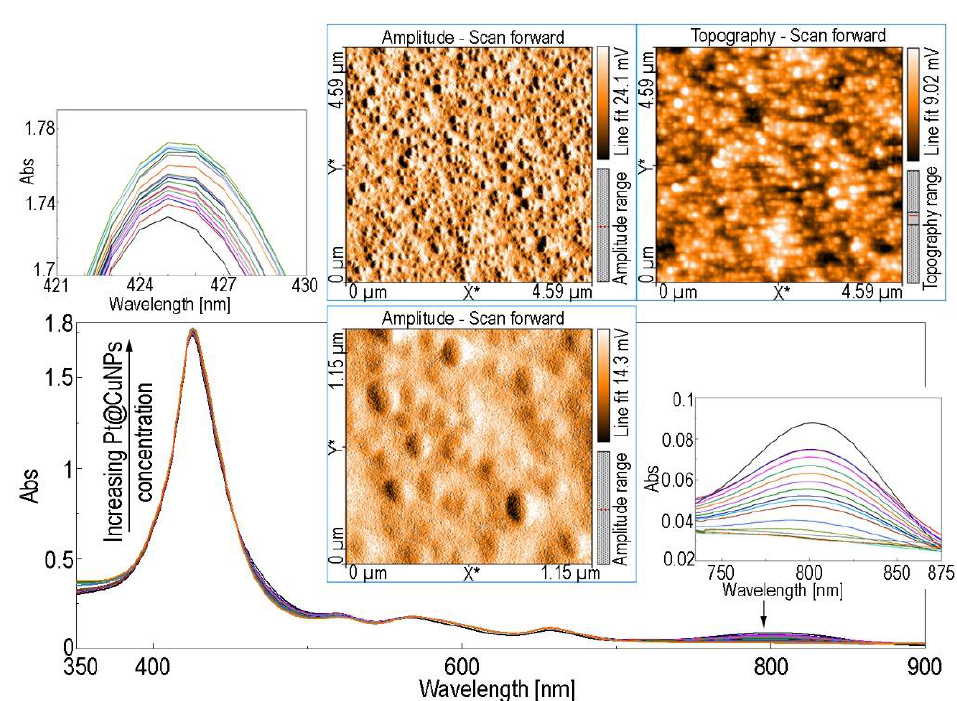
Figure 6. UV-Vis spectrometry of obtaining the hybrid complex between Pt@CuNPs and TAmPP porphyrin and AFM images of complex.